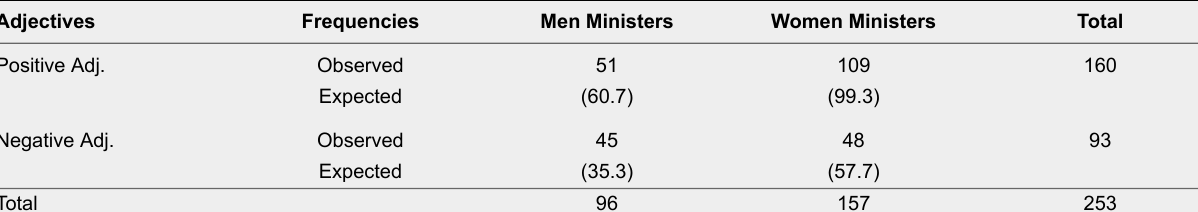
Distribution of Valence of Adjectives by Gender of Ministers